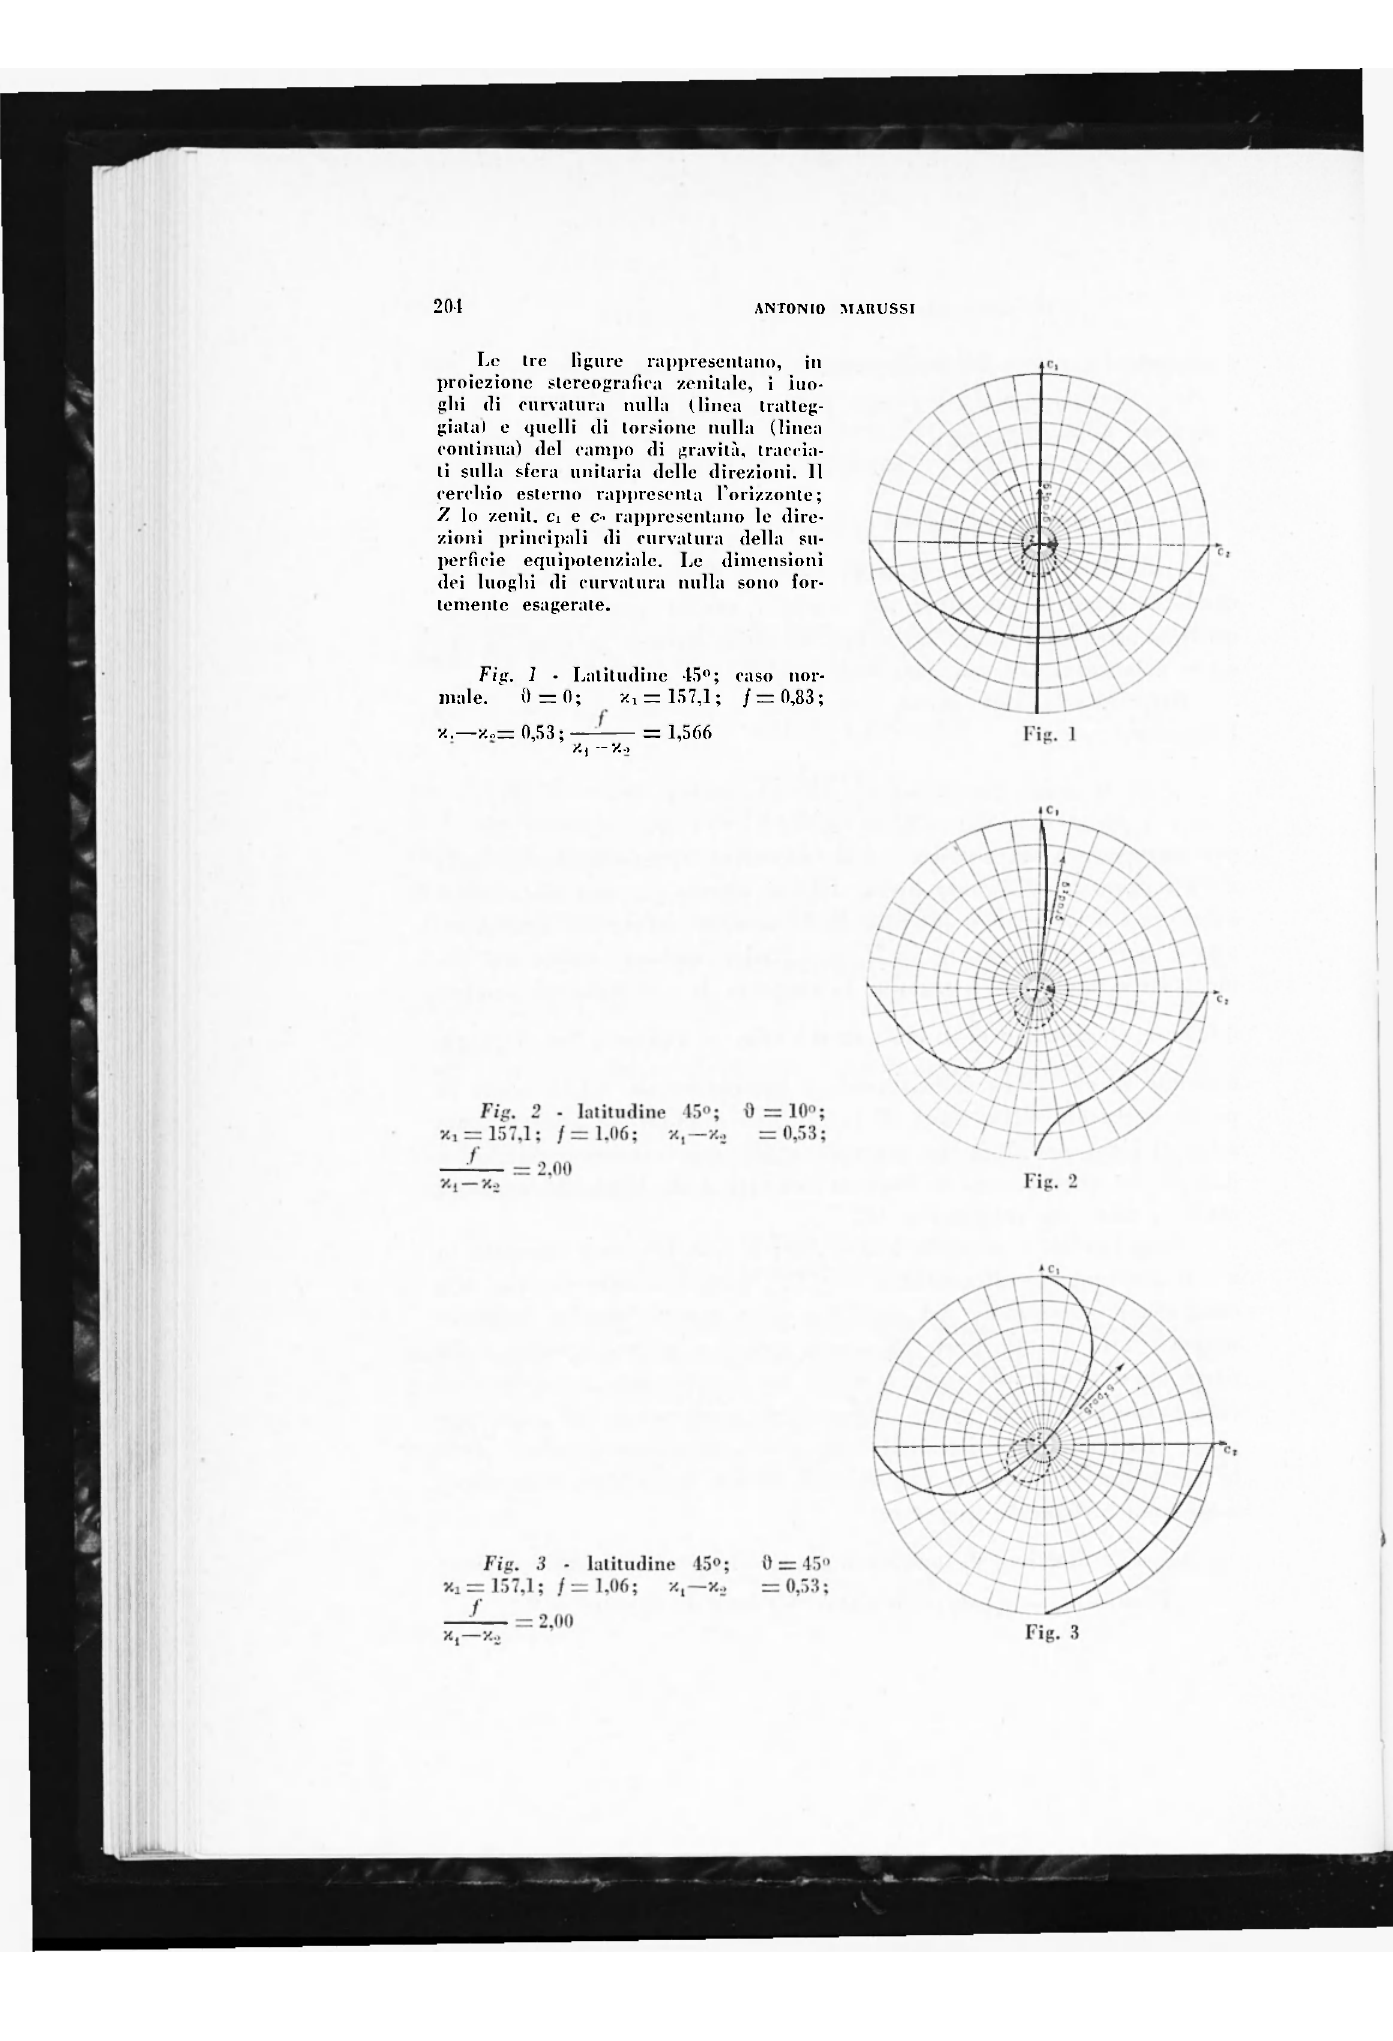
Fig. 1 - Latitudine 45°; caso nor- m a l